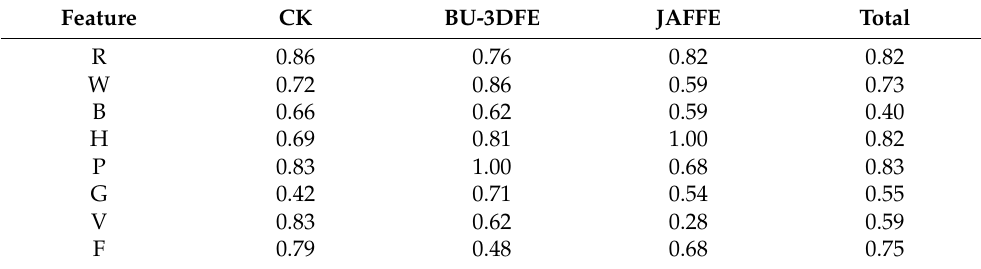
Table 10. Frequency of features in selected combinations for the CK+, BU-3DFE, and JAFFE data sets. RAW: (R), GW: (W), LBP: (B), HOG: (H), LPQ: (P), GEO: (G), VGG: (V), VGGF: